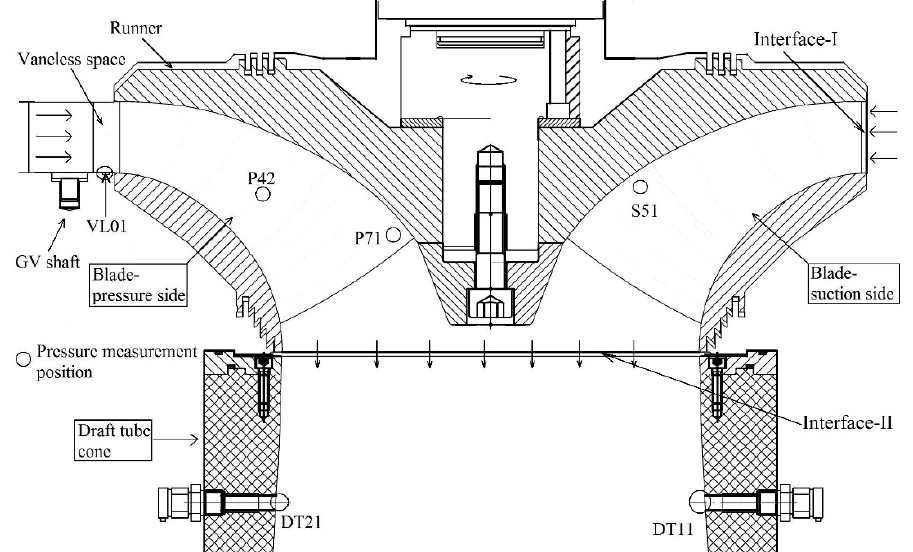
Figure 1. Locations of the six sensors for pressure measurements at runaway operating condition: VL01, vaneless space; P42, blade pressure side; P71, blade pressure side trailing edge; S51, blade suction side; DT11 and DT21, draft tube cone; GV, guide vane; Interface-I and Interface-II correspond to the inlet and outlet of the rotating domain, i.e. , the runner. Table 1. Dimensionless radial and axial positions of pressure sensors mounted in the turbine;